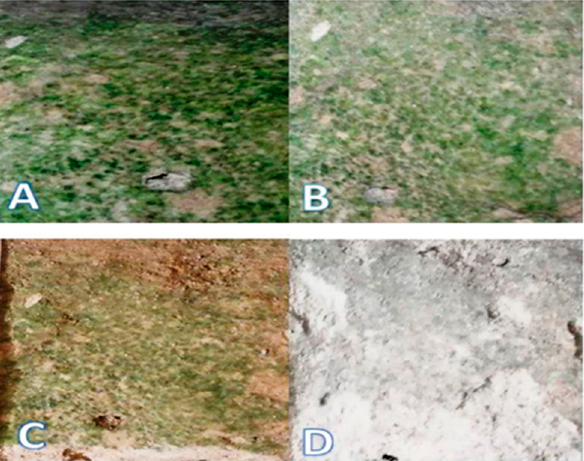
Figure 8. Color appearance of the bio-patina in the hypogeum of San Pietro Barisano during the treatment period with glycoalkaloids: ( A ) before the treatment; ( B ) post-1 week; ( C ) post-2 weeks; ( D ) post-4 weeks.